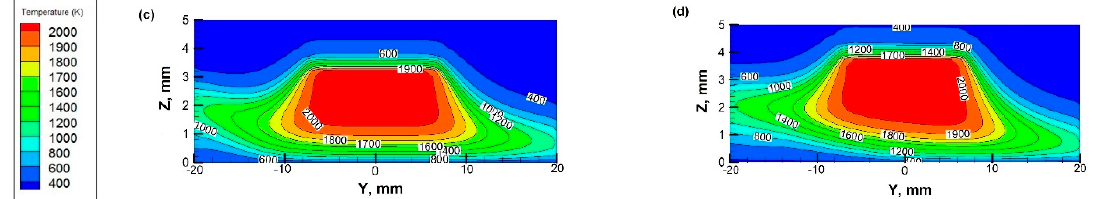
Figure 7. Temperature contours at different rotational speed in Y-Z plane (unit: K): ( a ) ω = 0; ( b ) ω = 100 rpm; ( c ) ω = 300 rpm; ( d ) ω = 600 rpm.